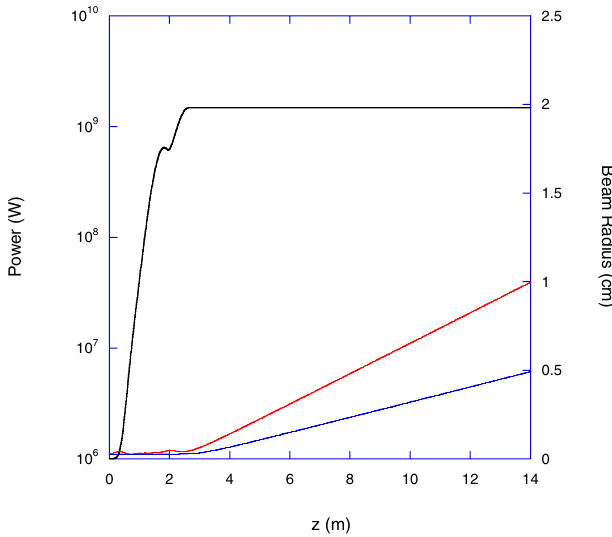
FIG. 7. (Color) Power (black), optical beam radius (red), and electron beam radius (blue) over a large distance for a matched- beam FEL with a two-stage wiggler.